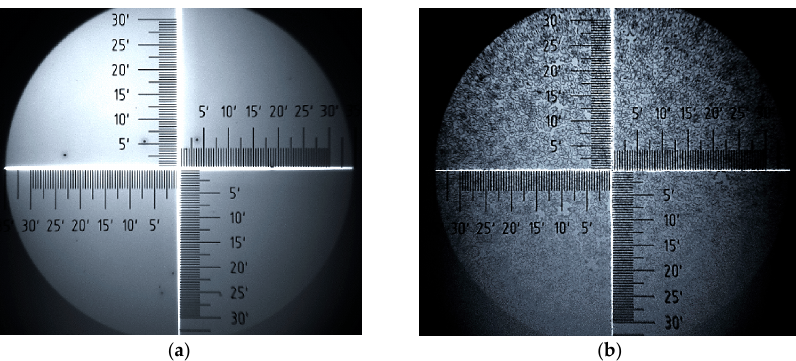
Figure 10. P3HT:PC60BM before ( a ) and after annealing ( b ).